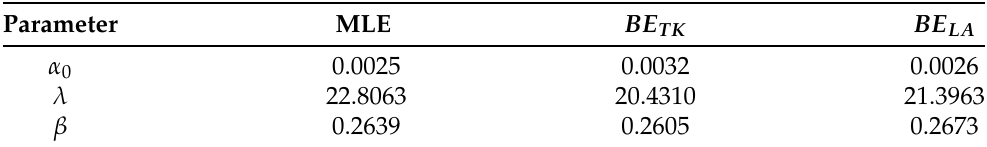
Table 11. The maximum likelihood estimates (MLE) and the Bayes estimates using the Tierney and Kadane technique ( BE TK ) and Lindley’s approximation ( BE LA ).